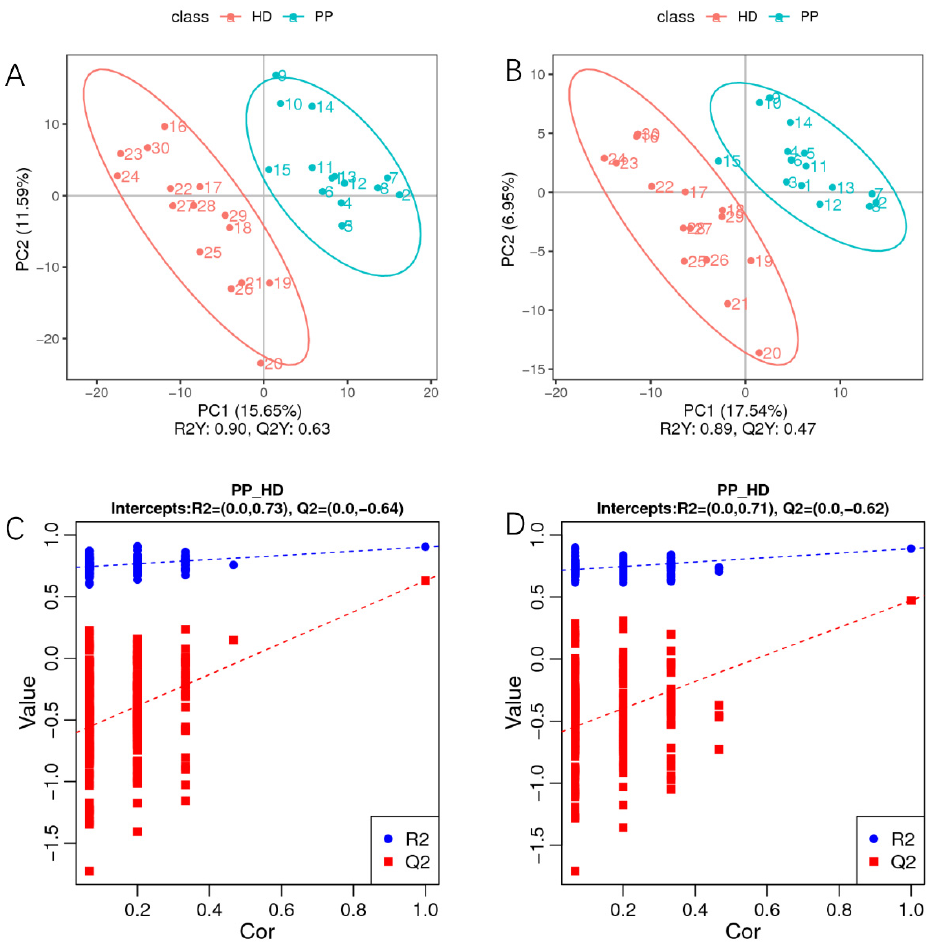
Figure 3. The partial least squares discrimination analysis (PLS-DA) of differential metabolites of endometrium in dogs with pyometra and healthy dogs. ( A , B ). The scattered plot: the classification parameters (R2Y) were 0.90 and 0.89 in positive ( A ) and negative ( B ) ionization modes; ( C , D ). The sorting inspection plot: the intercept values of R2 and Q2 were (0.0, 0.73) and (0.0, − 0.64) in positive mode ( C ) and (0.0, 0.71) and (0.0, − 0.62) in negative mode ( D ).